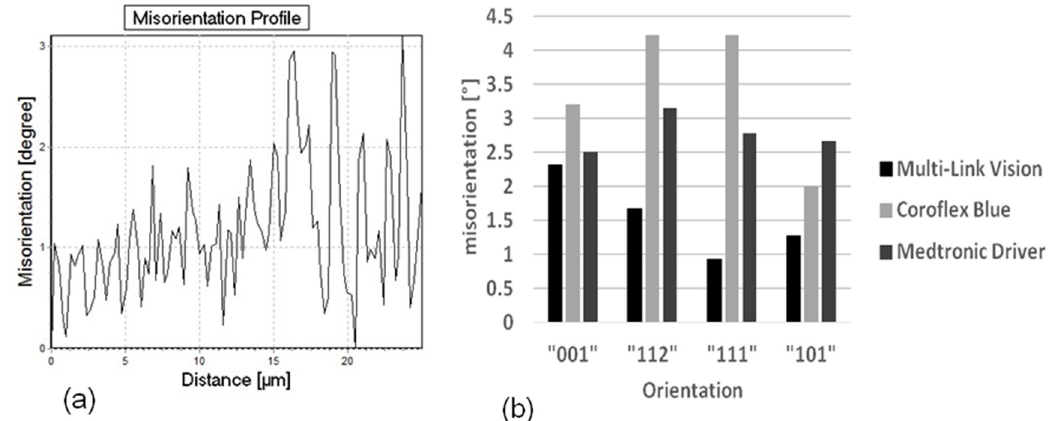
Figure 6. ( a ) Representative misorientation profile and ( b ) Maximum misorientation for different stent designs as a function of the grain